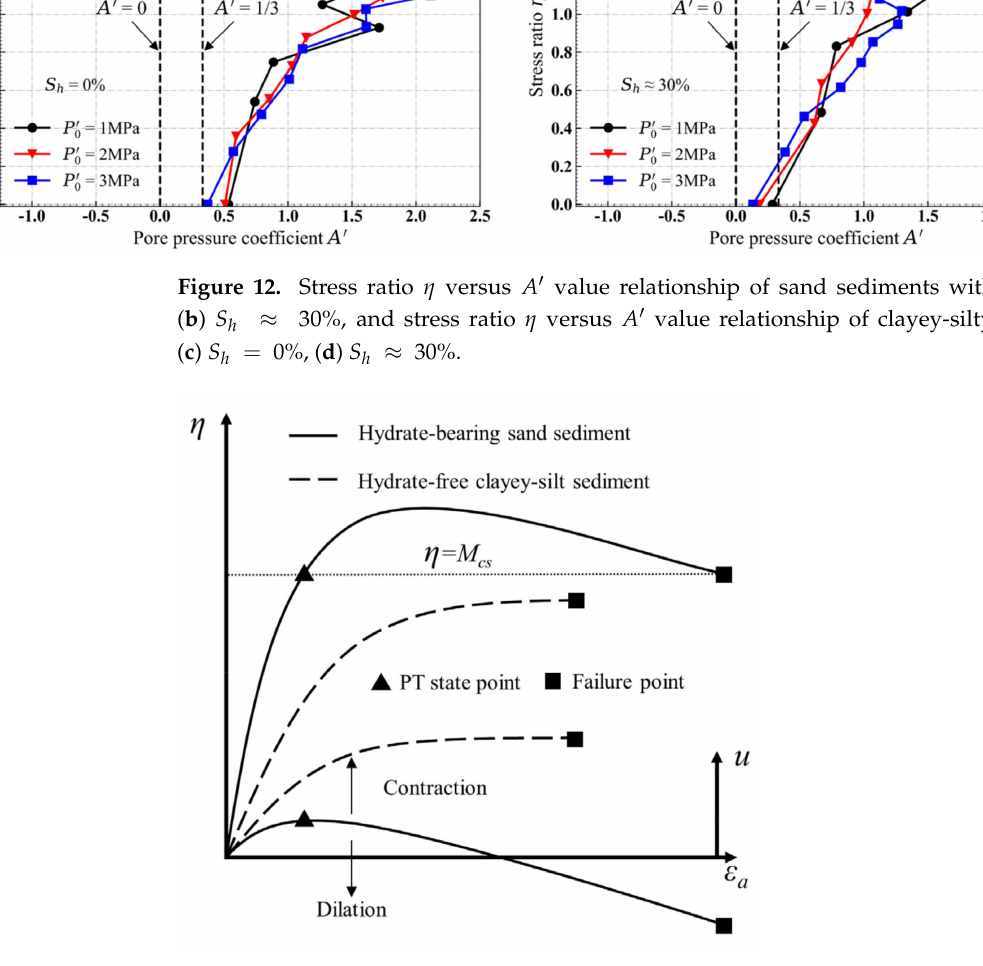
Figure 13. Typical mechanical characteristics curves for different hydrate-bearing sediments in triaxial compression tests under undrained